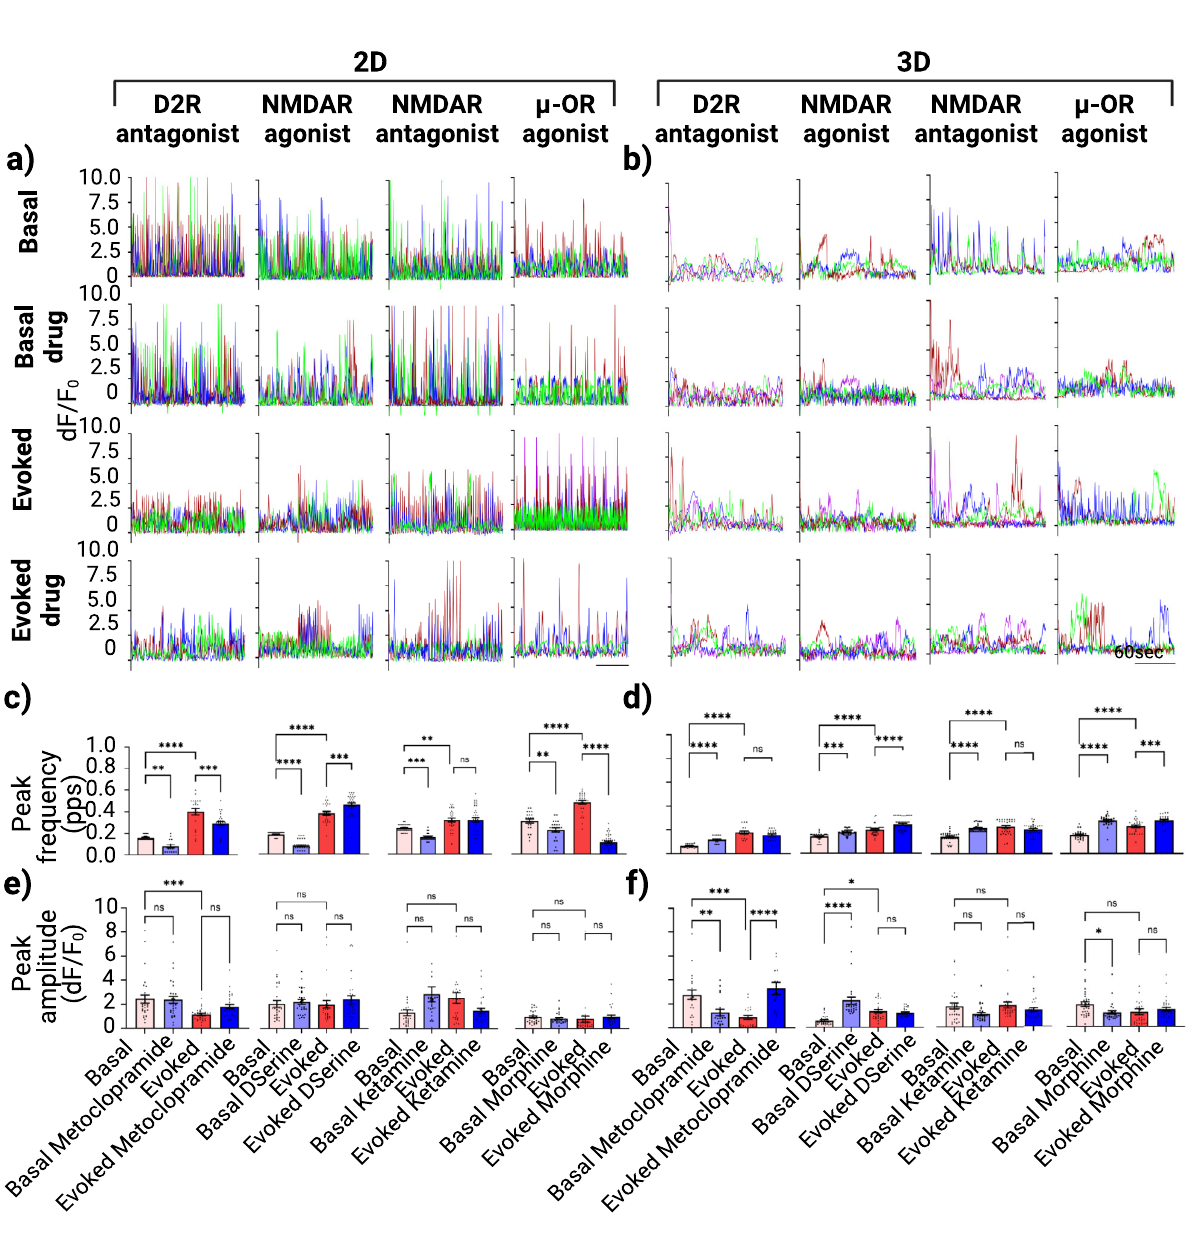
Fig. 5 Pharmacological modulation of image-based single cell calcium fl ux for 2D and 3D iDopas/iAstros cellular co-cultures. a , b Example of ROIs from every pharmacological experiment with each physiological variations; Basal, Basal with drug, Evoked, Evoked with drug; for the 2D and 3D co-cultures models, respectively. Quantitative measurements of calcium peak frequency ( c , d ) and mean peak amplitudes from each ROIs ( e , f ), the spontaneous and evoked calcium fl ux, for 2D and 3D co-cultures for each drug tested. Minimal of three ROIs from each well and three technical replicates, each with 3 wells per group were plotted as bar graph. Error bar s.e.m., Statistics: Two-way ANOVA with post hoc turkey test between